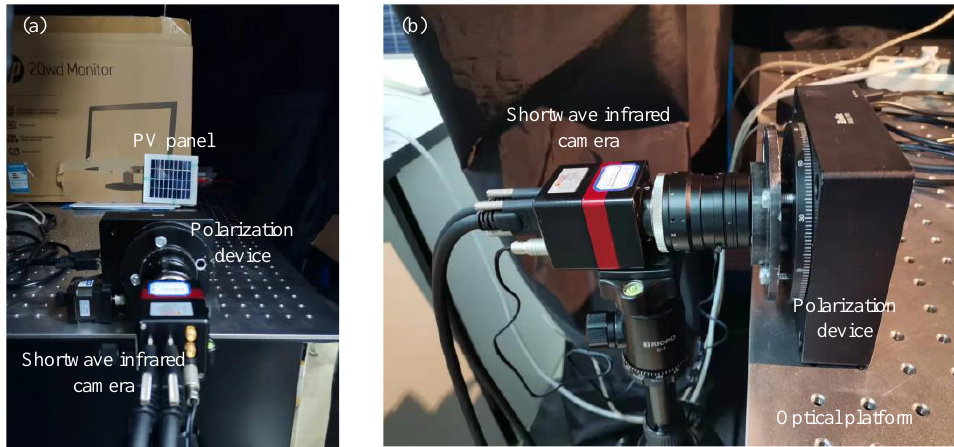
Figure 4. Experimental spot ( a ) Front view; ( b ) Side view.